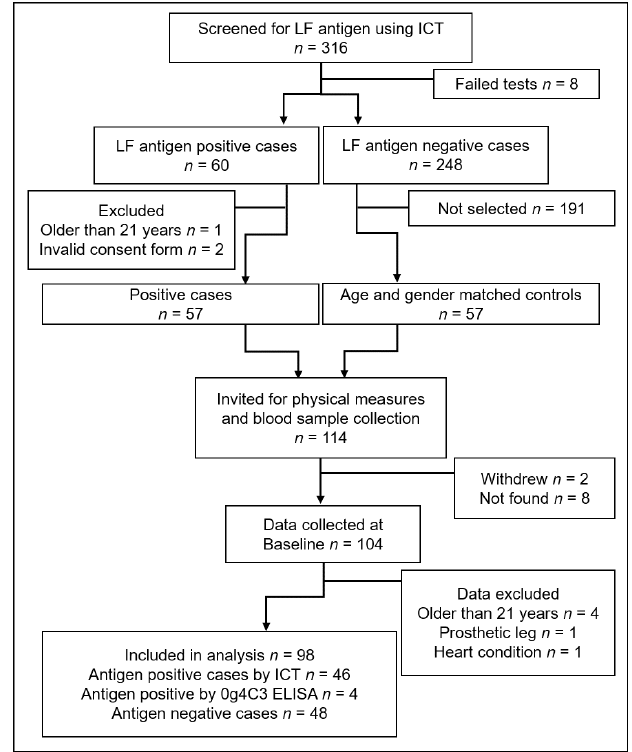
Figure 2. Flow of participants through recruitment, screening, and baseline data collection.